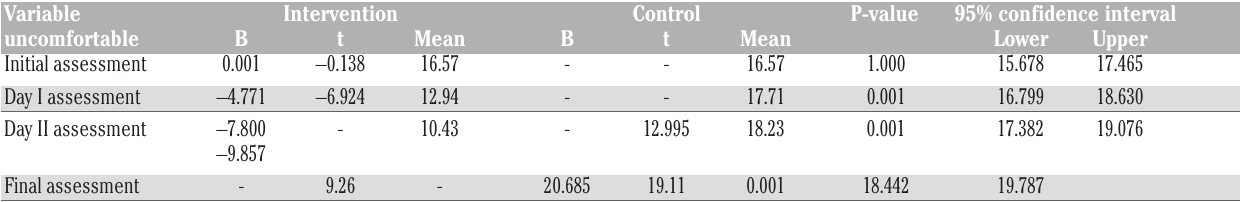
Table 2. Effect of use of breastfeeding pillows on decreasing maternal discomfort in control and intervention groups. Variable